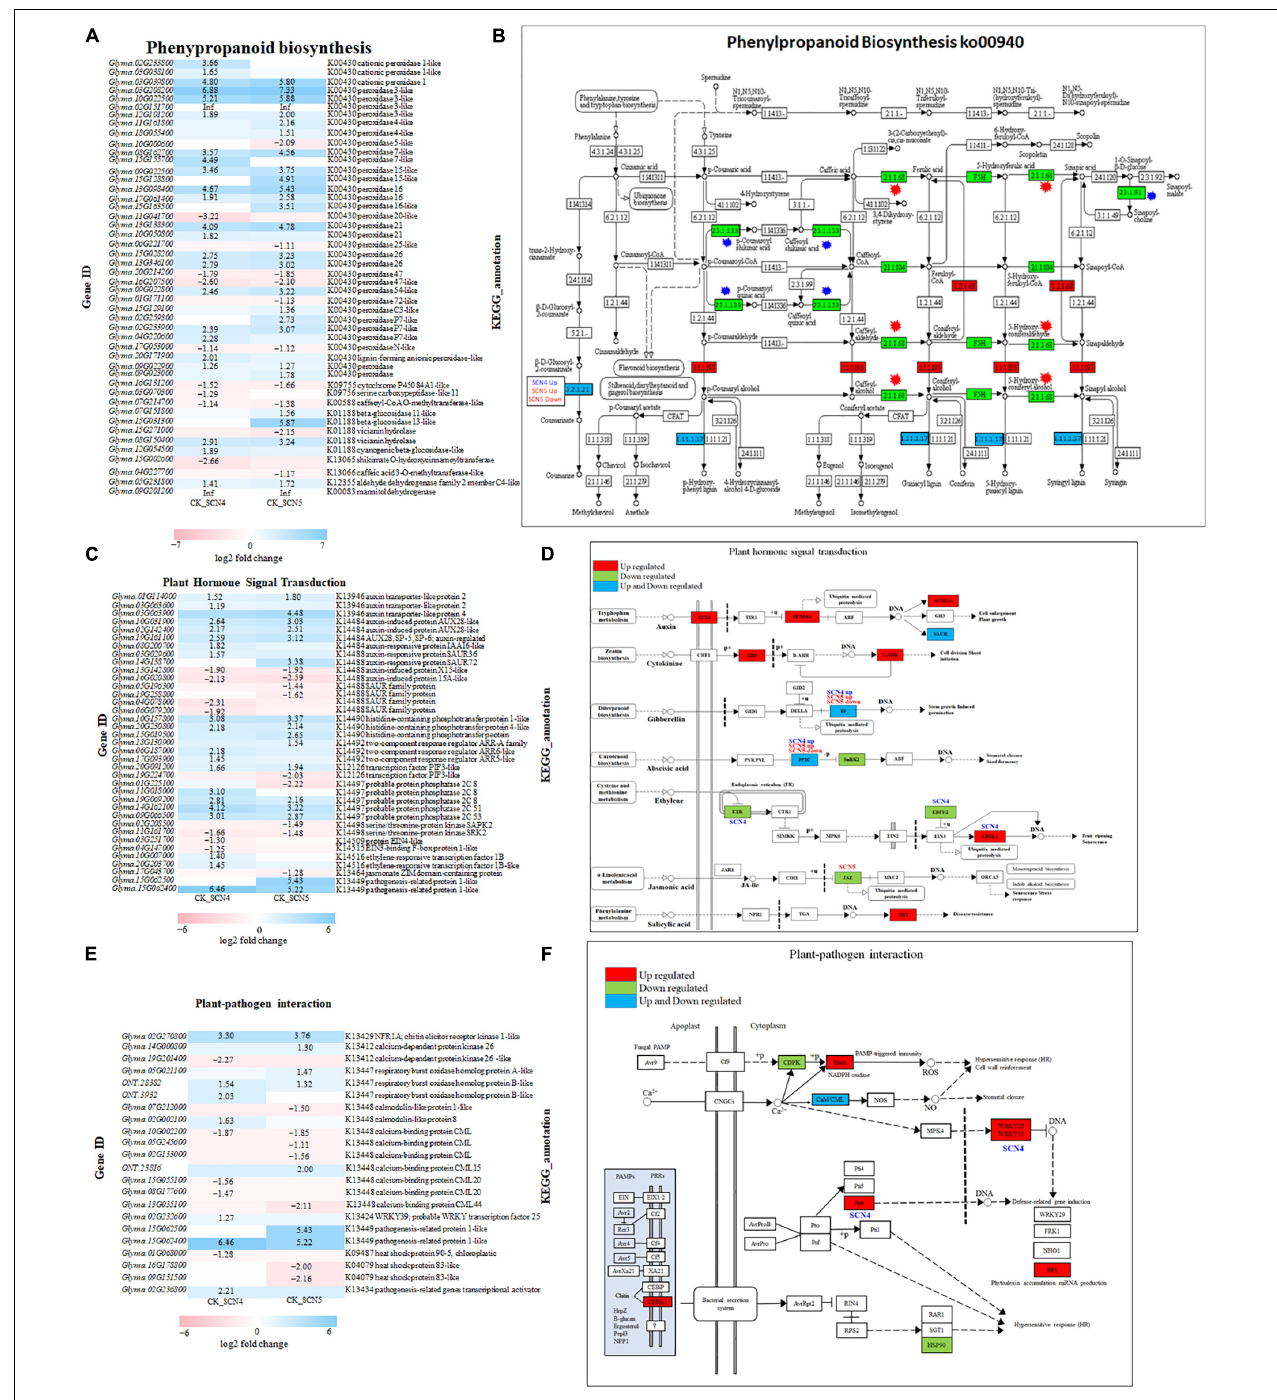
FIGURE 7 | Gene expression and KEGG pathway in phenylpropanoid biosynthesis (https://www.genome.jp/pathway/map00940) (A,B) , plant hormone signal transduction (https://www.genome.jp/entry/map04075) (C,D) and plant-pathogen interaction (https://www.genome.jp/entry/map04626) (E,F) in soybean infected with SCN4 (soybean cyst nematode race 4) and SCN5. (A,C,E) represent the expression level of differentially expressed genes (DEGs) associated with the corresponding pathway for either CK (control) -SCN4 and/or CK-SCN5; white blank block (0) means no expression variations detected with Fold Change ≥ 2 and False Discovery Rate (FDR) < 0.05; the left side of the y -axis is gene ID, and the right side is the corresponding KEGG annotation. (B,D,F) are KEGG pathways; the blocks in red, green, and blue colors indicate DEGs in upregulation, downregulation, or both ways for both CK-SCN4 and CK-SCN5, respectively, except for the special note for DEGs only found in either SCN4/SCN5 or either up-/downregulation; in panel (B) , blue star represents the enzyme DEG found only in CK-SCN4, and the red star represents the enzyme DEG found only in CK-SCN5.